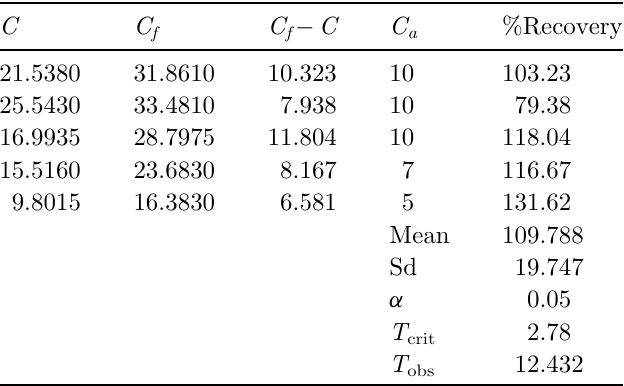
Table 10. Result of recovery study of cadmium quanti- fi cation in bivalve molluscs using an atomic absorption spectrometry with graphite furnace method